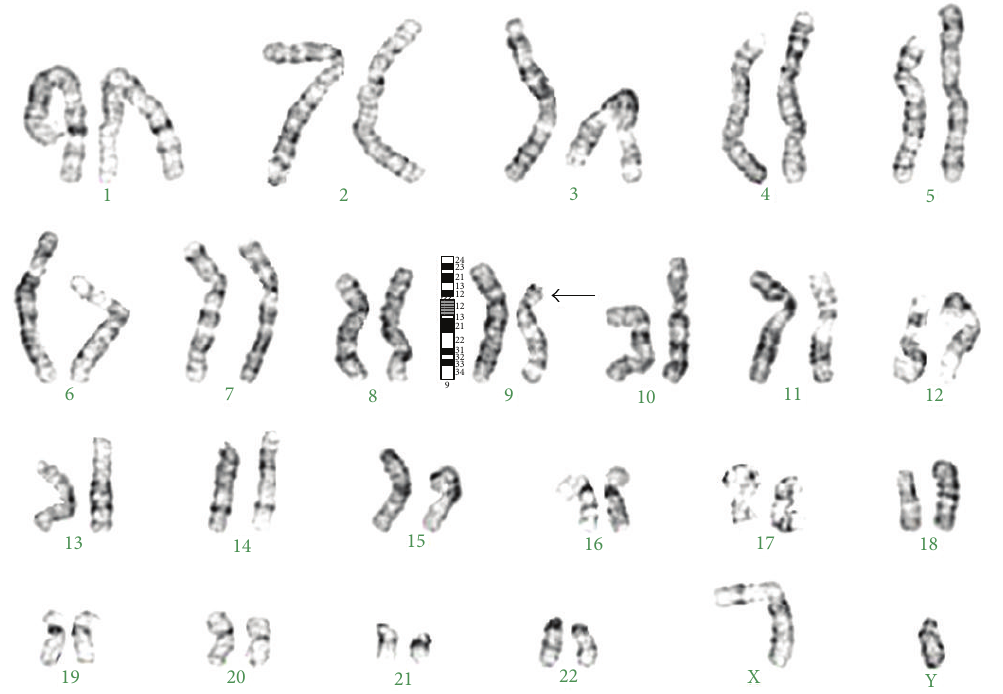
Figure 2: Karyogram showing terminal deletion in the short arm of chromosome 9 [46,XY,del(9)(p22 →